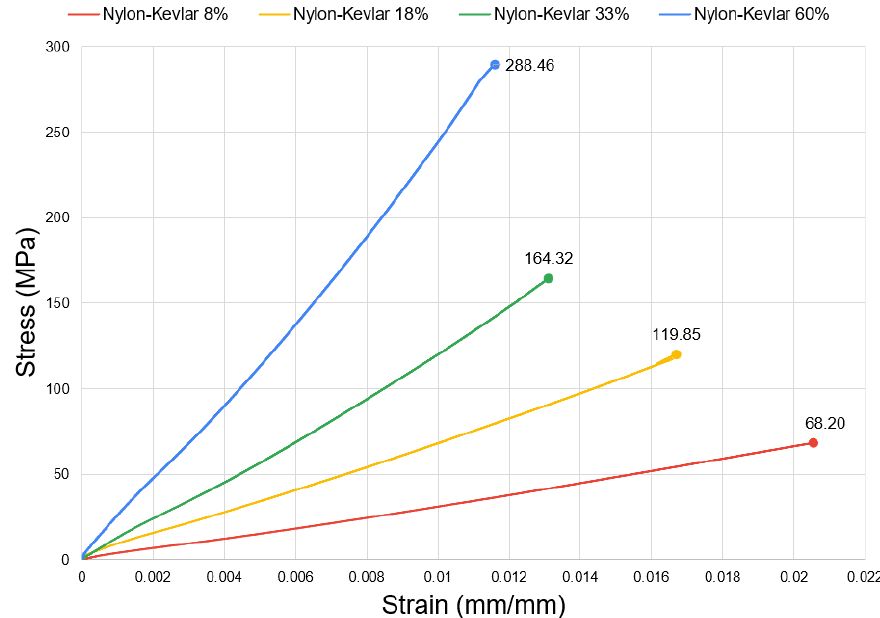
Figure 8. Effect of Kevlar volume fraction on tensile strength of CFRAM nylon-Kevlar.